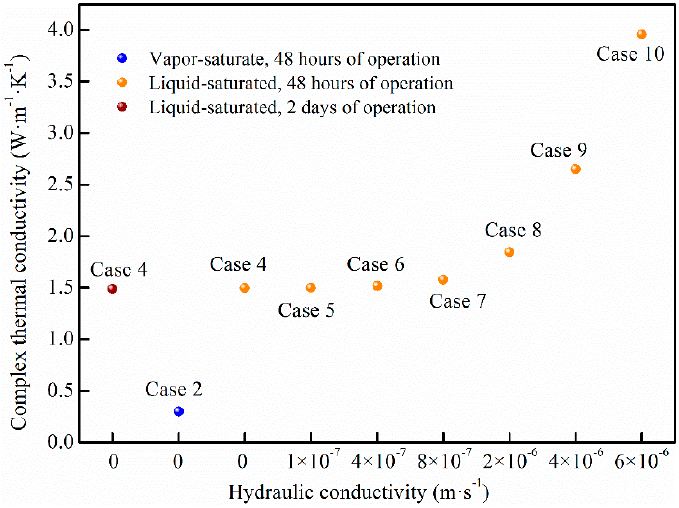
Figure 15. Complex thermal conductivities of CPB with different hydraulic conductivities.